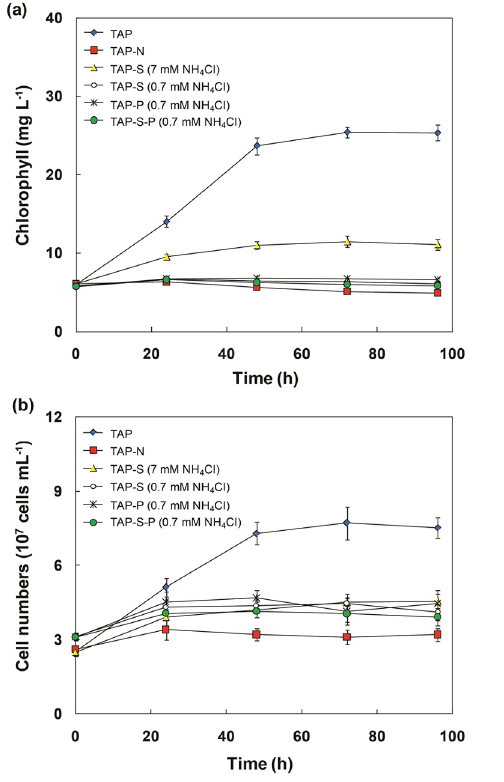
Fig. 5. Change in chlorophyll a fluorescence parameter F / F (a), Φ PSII(b) in C. sorokiniana incubated in TAP, v m Cl), TAP-N, TAP-S (7 mM NH Cl), TAP-S (0.7 mM NH Cl), TAP-P 4 4 4 Cl), TAP-S-P (0.7 mM NH Cl), TAP-S-P (0.7 mM NH Cl) media. 4 4 4